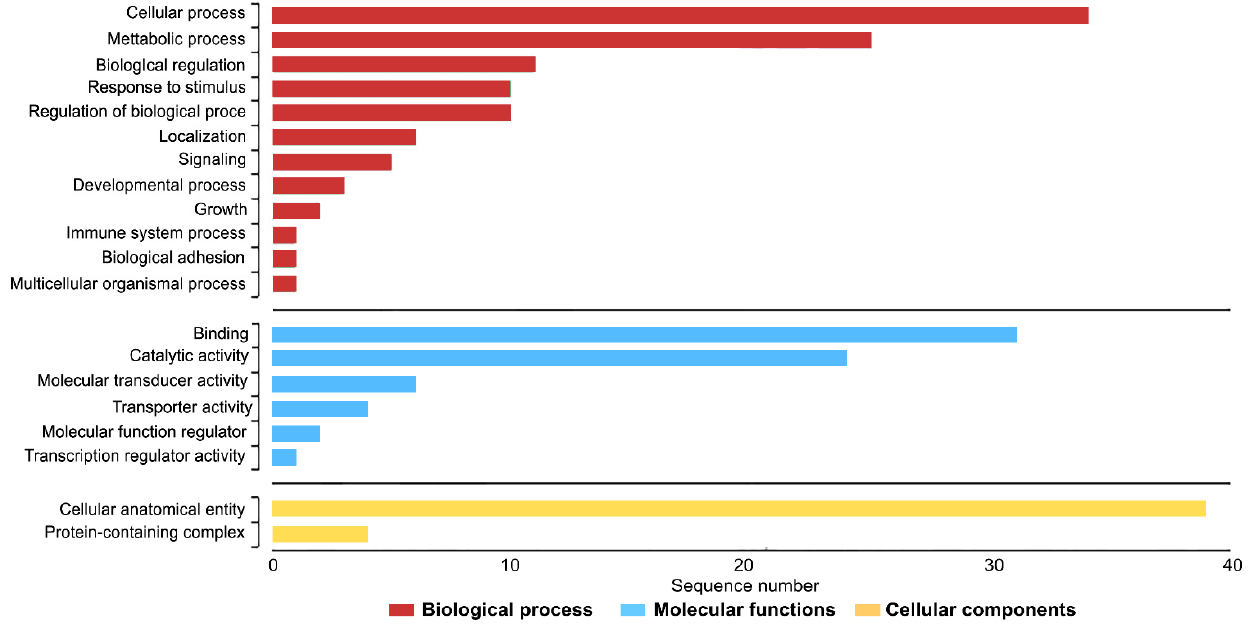
Figure 5 . Gene ontology (GO) functional classification of sex-specific loci of Siamese fighting fish ( Betta splendens Regan, 1910) [1] using Blast2GO. Histograms of the frequency of transcripts annotated to specific GO categories; biological process, molecular functions, and cellular components are represented by red, blue, and yellow bars, respectively .